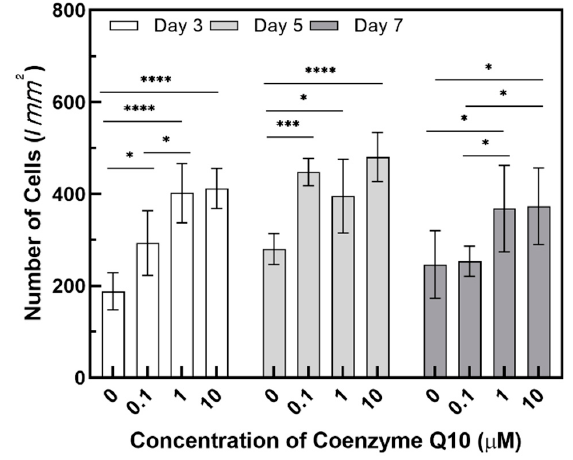
Figure 6. Variation of the thickness of the epidermal layer as a function of the coenzyme Q10 concentration after 3 days, 5 days, and 7 days of air exposure ( p -value: * < 0.05, ** < 0.01, *** < 0.001, and **** < 0.0001).